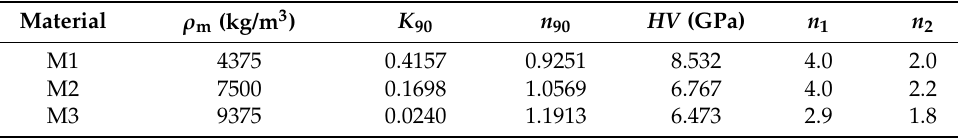
Table 1. Material properties and erosion coefficients of the wear-resistant plate materials.